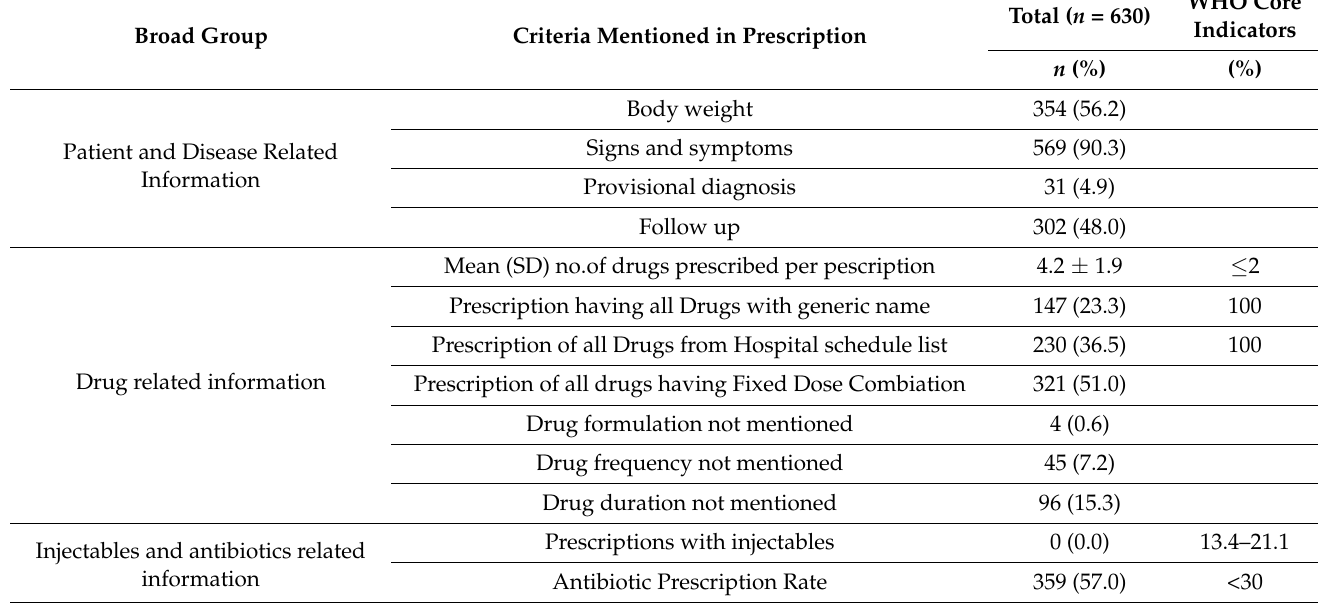
Table 2. Completeness of prescriptions as per different criteria according to disease and comparison with WHO core